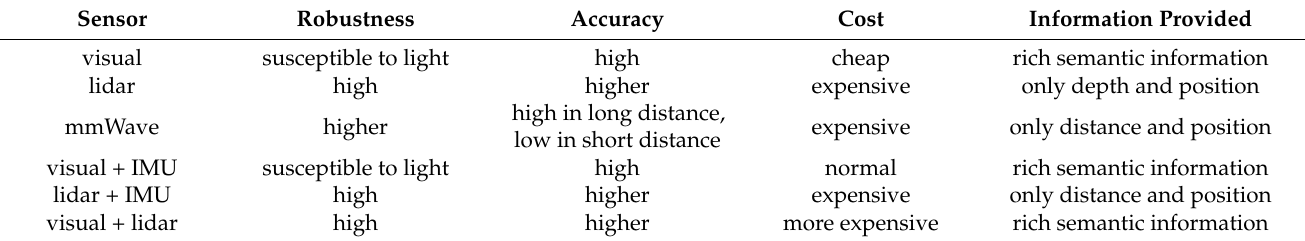
Table 1. The advantages and disadvantages of different